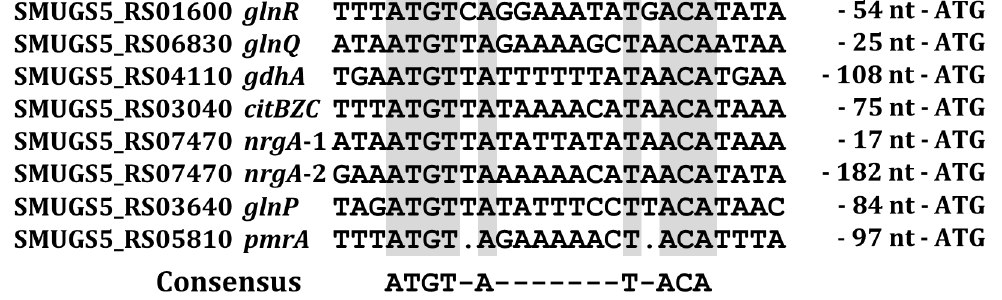
Fig 2. Alignment of the GlnR box of the S . mutans GS5 GlnR regulon genes. The distance between the GlnR box and the translational start site of each gene is